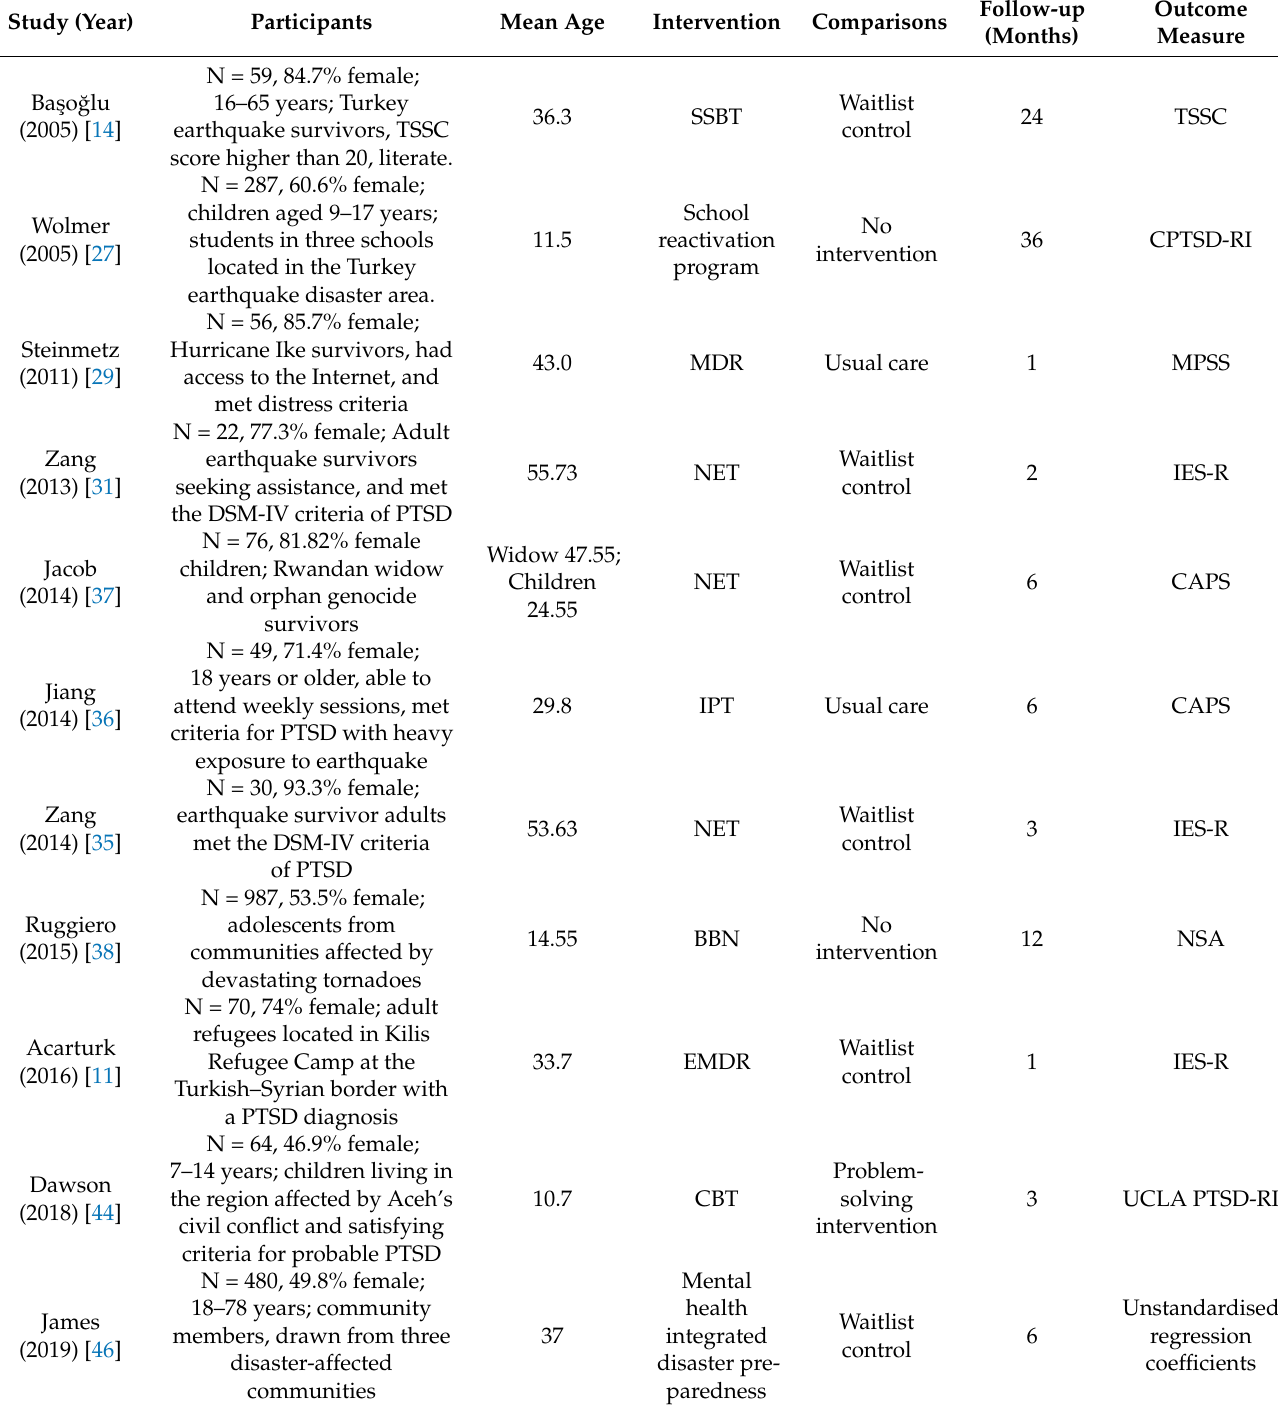
Table 5. Summary characteristics of PTSD focused studies, according to study